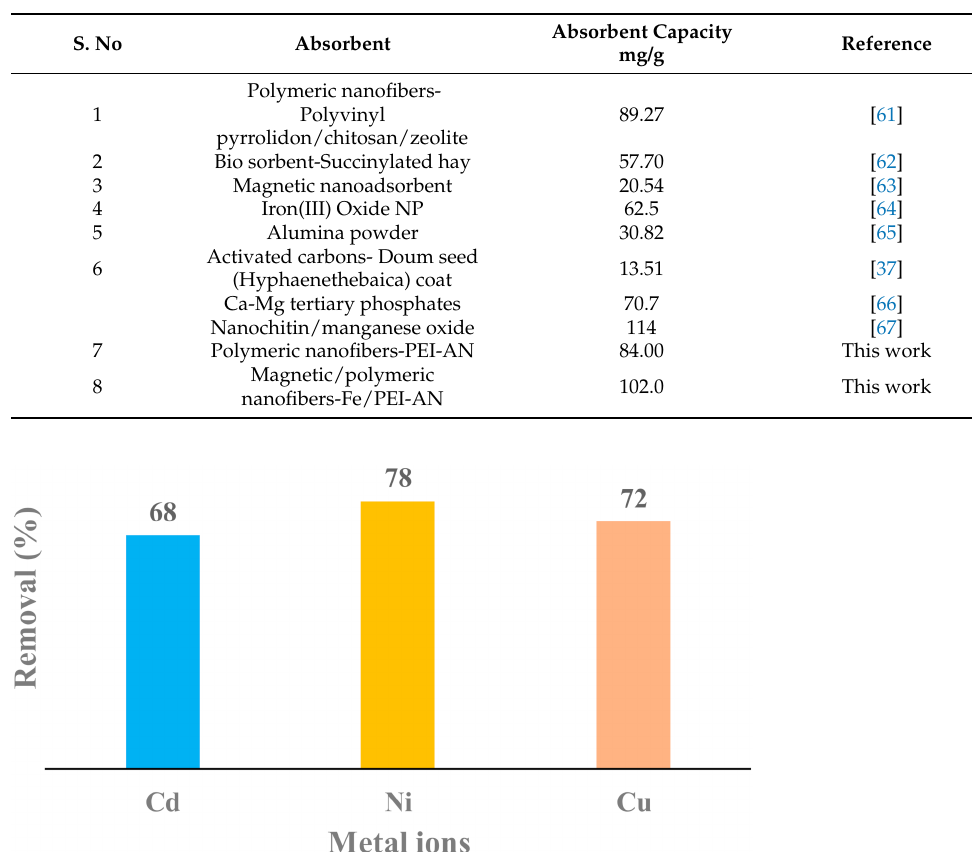
Table 6. Comparison of present adsorption capacity of Ni 2 + with previous studies.